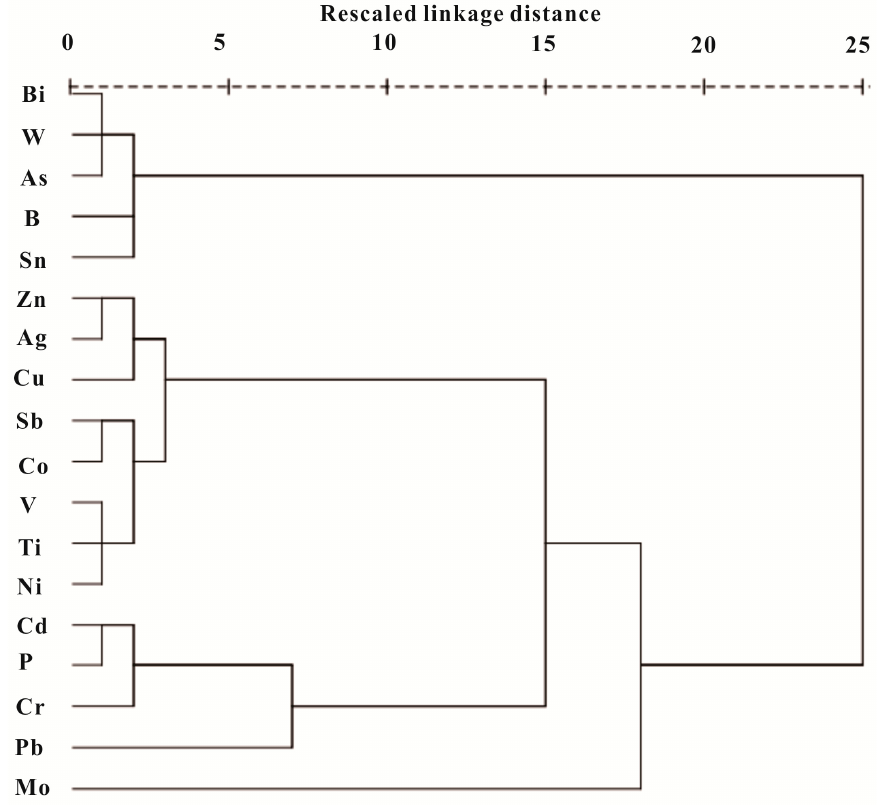
Figure 4. Dendgram of target metals and phosphorus using hierarchical clustering analysis for parameters.